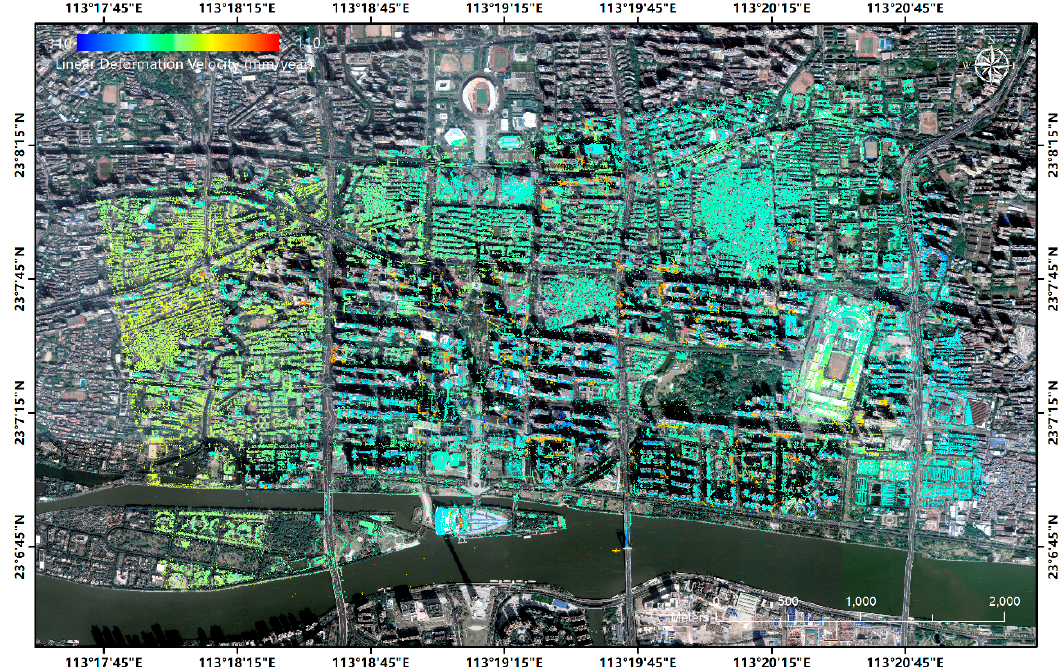
Figure 8. Linear deformation map generated from standard processing results using PS points with a temporal coherence bigger than 0.85.